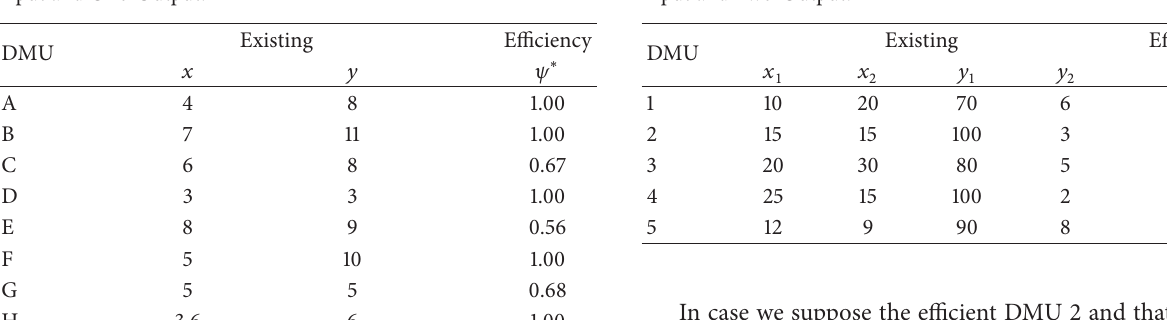
Table 1: The Data and Results Obtained from Model (3) with One- Input and One-Output.